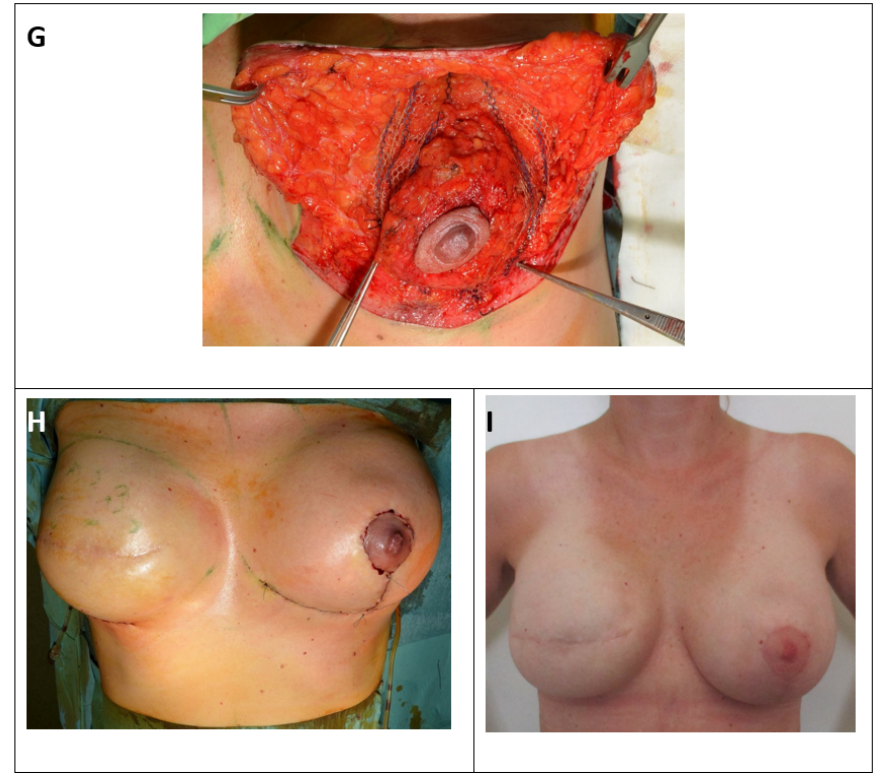
Figure 2. Surgical therapy for inferior or modified central pedicled inverted ‐ T mastopexy with ULTRAPRO ® sling mesh ( A ) Preoperative drawings of inverted ‐ T symmetrization mastopexy on the left side and expander ‐ to ‐ implant changes on the right side. ( B ) Skin reduction via de ‐ epithelization of the preoperatively marked skin on the lower pole of the left breast. ( C ) Medial and lateral fascio ‐ cutaneous flaps are elevated from the breast parenchyma, and the Ultrapro mesh is placed towards the upper pole of the breast. ( D ) The fascia of the pectoralis major muscle at the upper pole is prepared as the point of mesh fixation. ( E ) ULTRAPRO mesh sling adapted with double absorbable sutures to the pectoralis major fascia of the upper pole. ( F ) The mesh sling was modelled in “trouser ‐ form” and placed in omega ‐ form around the de ‐ epithelialized parenchyma for suspension. ( G ) The divided mesh slings are adapted via absorbable sutures on the lower pole and medially and laterally on the sides of the parenchyma for flexible fixation. ( H ) Cosmetic outcome after skin closure. ( I ) 15 ‐ month postoperative result.